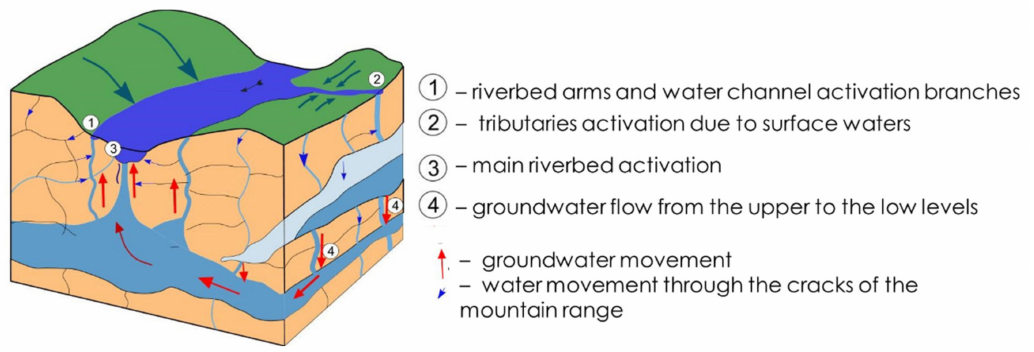
Figure 6. River functioning in a “normal” state.